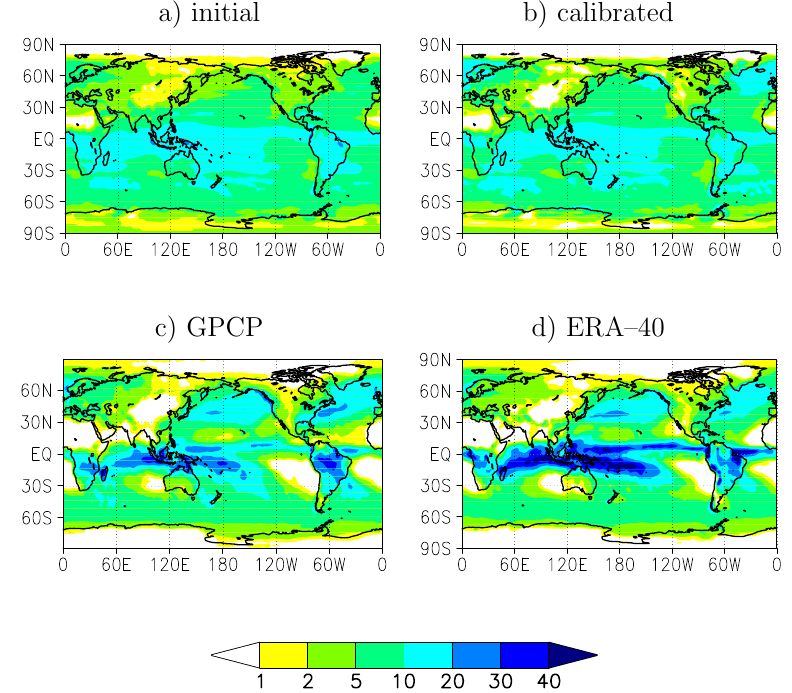
Fig. 12. Similar to Fig. 11 but for January total precipitation ( cmmo − 1 ).